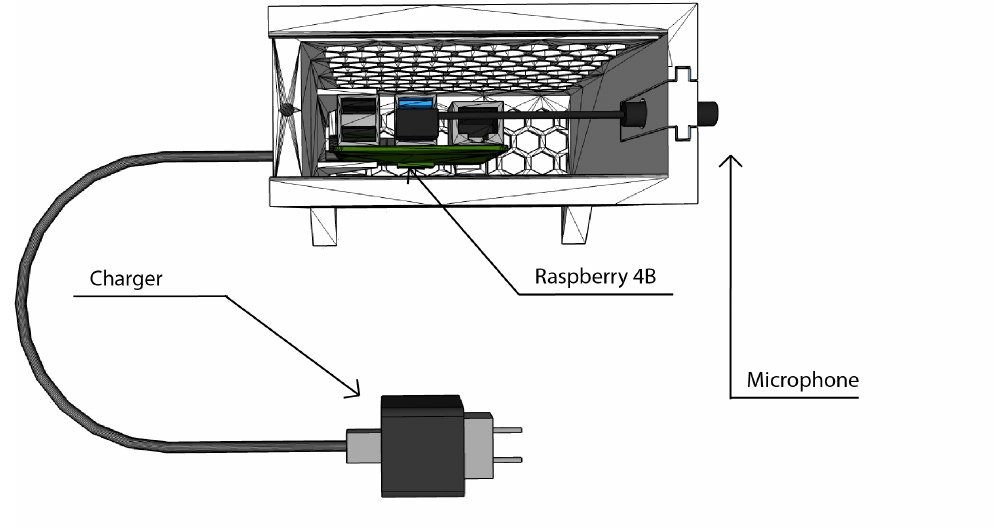
Figure 5. Conceptual integration of the hardware elements of the sensor. The 3D model of the Raspberry Pi has been retrieved from